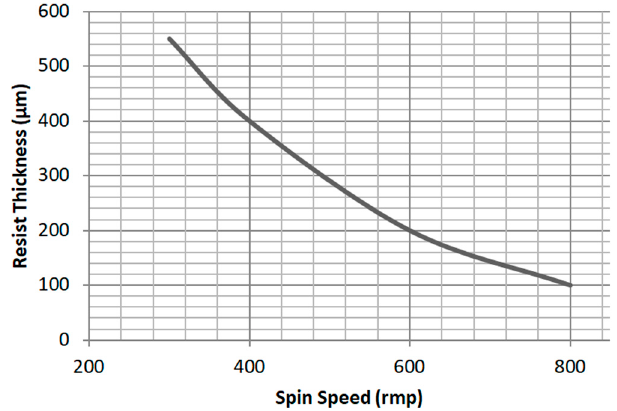
Figure 4. SU ‐ 8 2150 spin speed versus thickness. A spin speed of 400 rmp generates a 400 μ m ‐ thick SU ‐ 8 resist film.